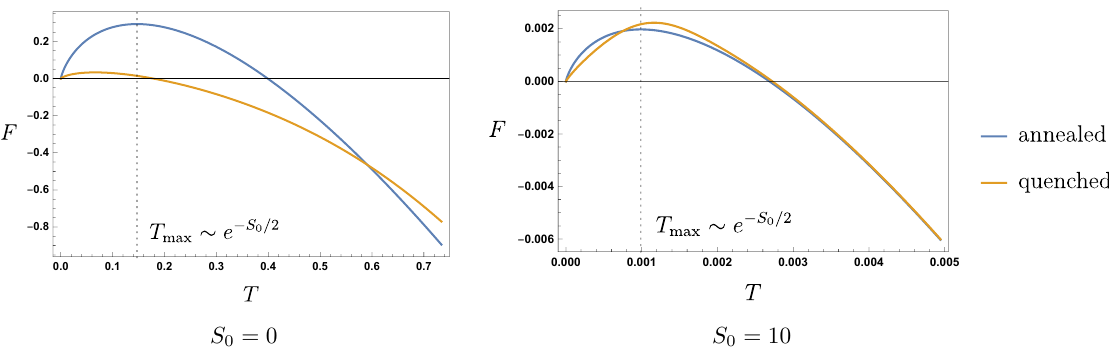
Figure 4 . Quenched and annealed free energies for the bump around T ∼ e − S 0 / 2 and become almost identical at large S 0